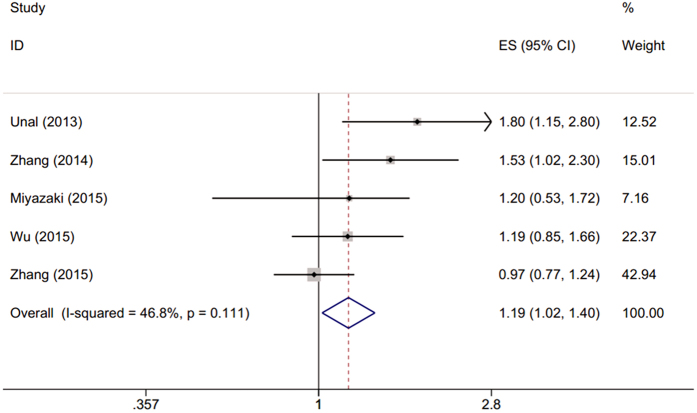
Forest plot of the association between PLR and DFS/PFS in patients with NSCLC.